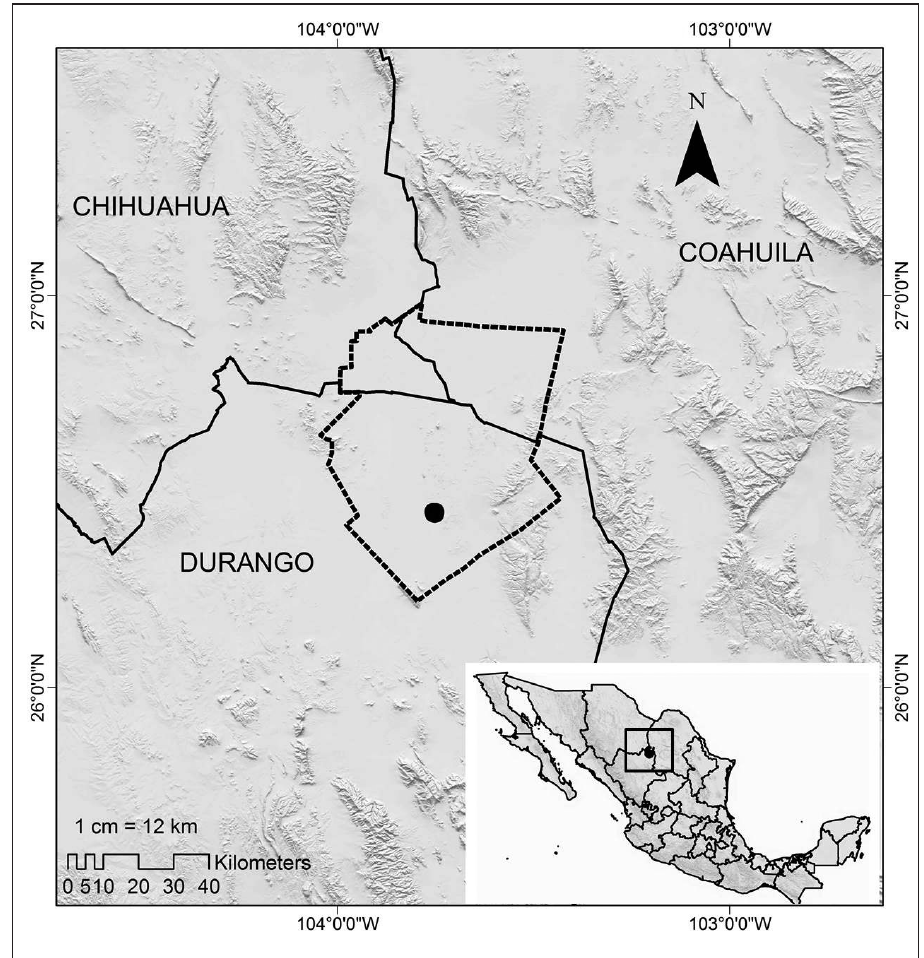
Figure 2. Study site. The black circle show Tortugas locality, in dotted lines is show The Mapimí Bio- sphere Reserve and continuous lines the state